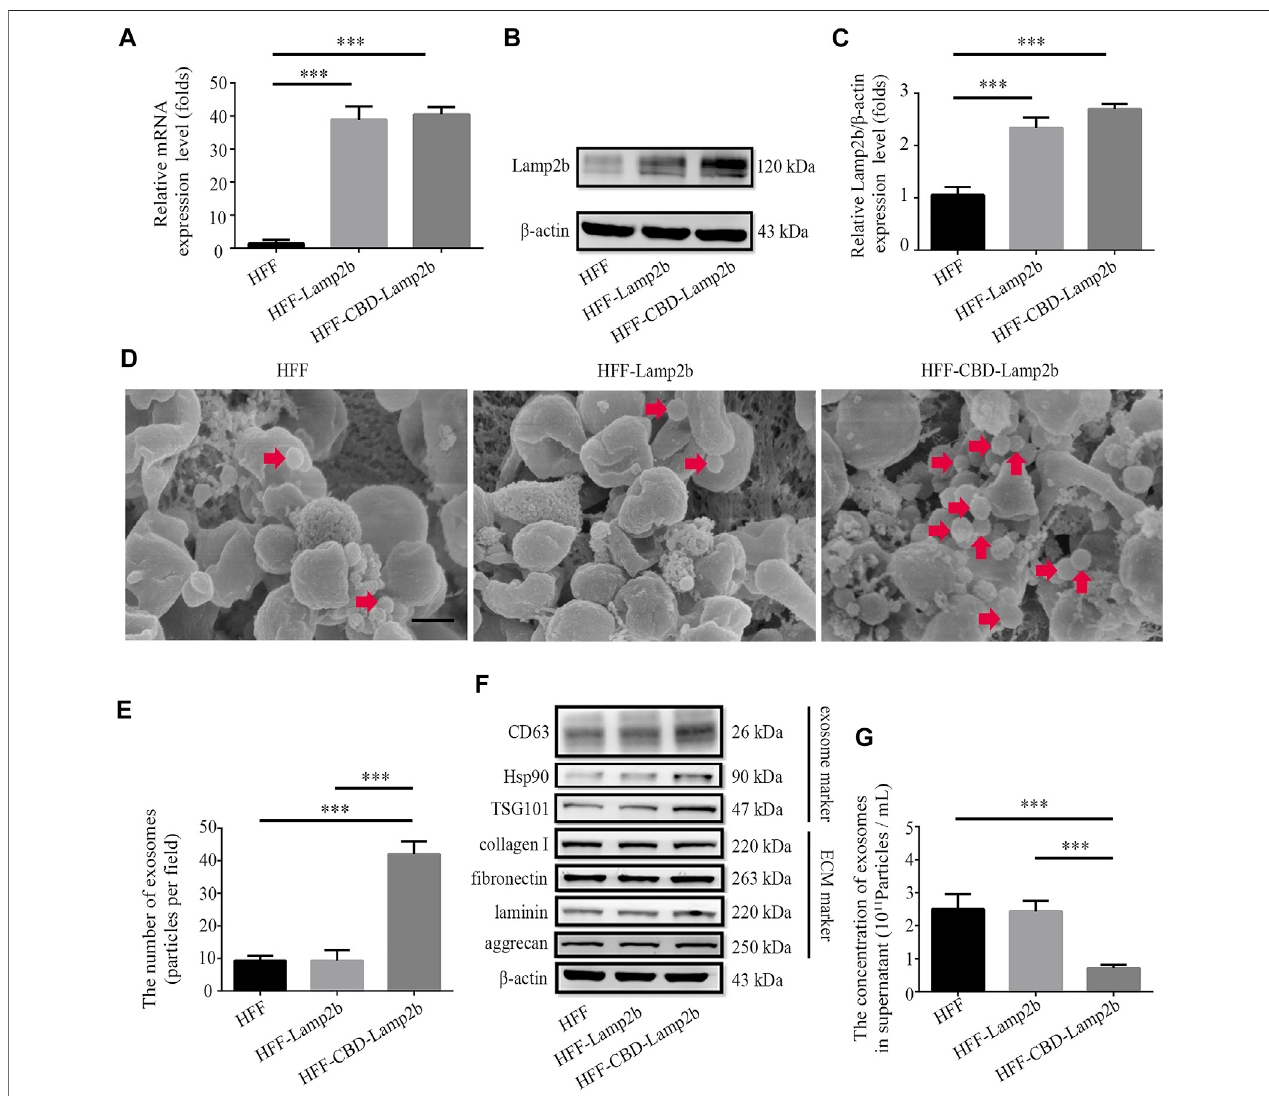
FIGURE 2 | Enrichment of exosomes surrounding the host cells. Overexpression of Lamp2b in HFF cells determined by (A) qRT-PCR and (B) Western blot. (C) RelativeexpressionlevelofLamp2bwasquanti fi ed.The β -actinwasusedasaninternalcontrol. (D) RepresentativeSEMimagesofindicatedcellsurface.Theredarrows indicatetheexosomessurroundingthehostcells.Scalebar (cid:1) 250 nm. (E) Thenumberofexosomesintheview. (F) WesternblotanalysisofexosomalmarkersandECM markers in indicated cells. (G) The NTA analysis of exosomal number in cell culture supernatants. Data are represented as mean ± SD ( n (cid:1) 3). ANOVA was performed; “ *** ” : p <